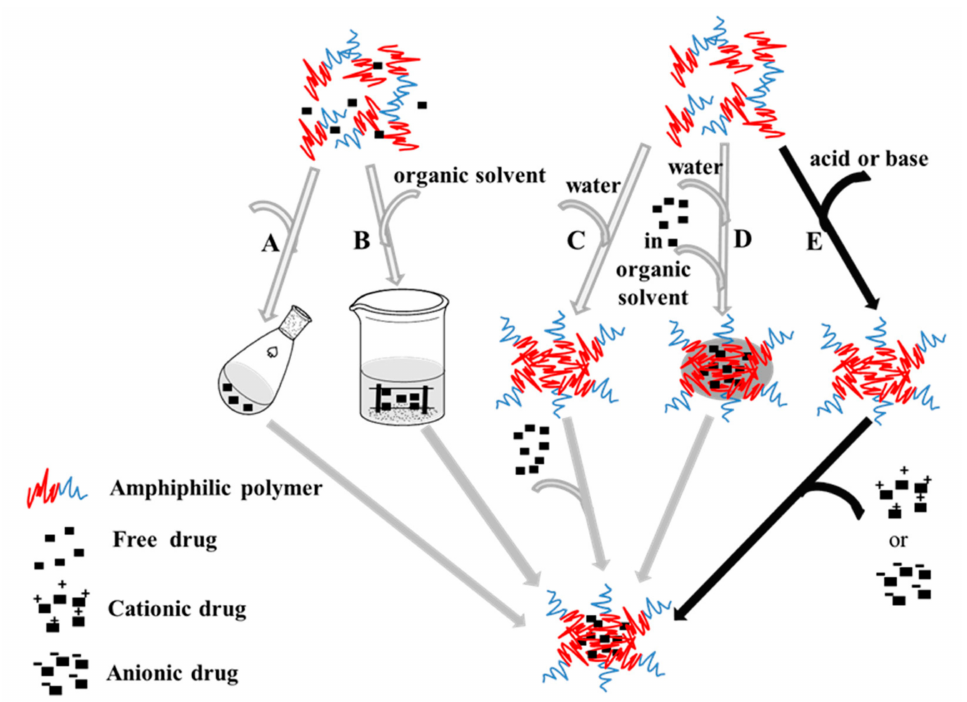
Scheme 2. An illustration of the different techniques to prepare polymeric micelles. ( A ) Thin film hydration method, ( B ) dialysis method, ( C ) simple equilibrium method, ( D ) oil in water